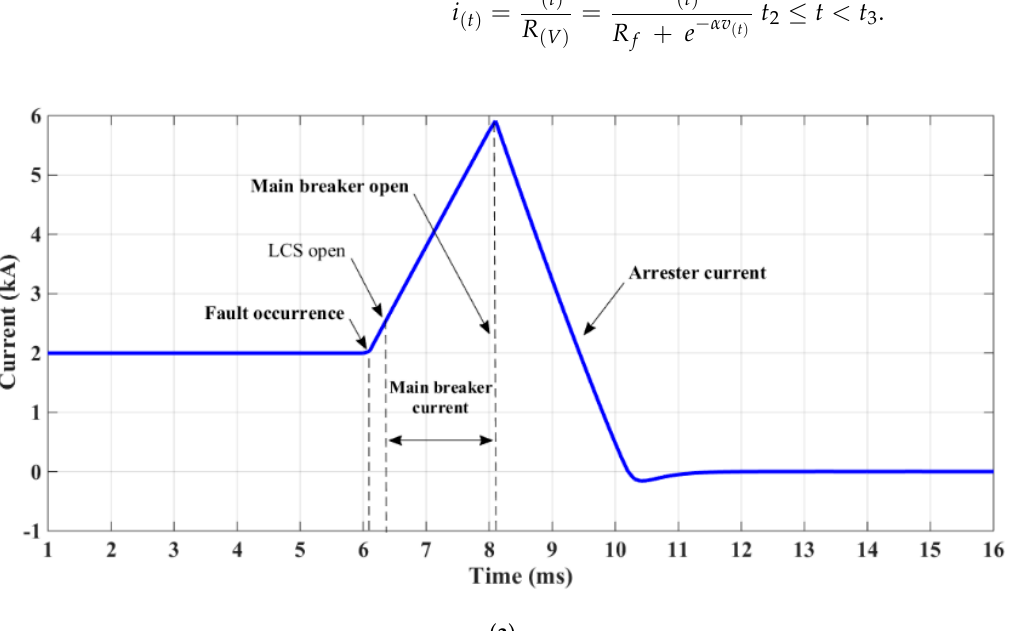
Figure 4. Simulated diagram of a DC system and a DC breaker.